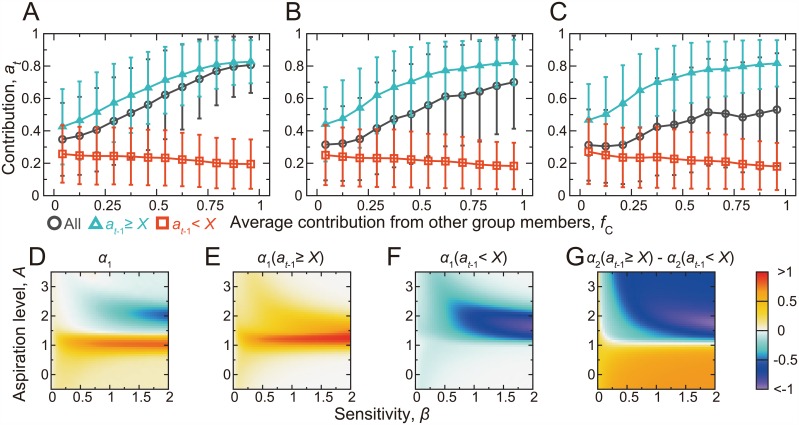
CC and MCC patterns in the repeated PGG in a group of four players.(A)–(C) Contribution by a player (i.e., at) conditioned on the average contribution by the other group members in the previous round (i.e., fC). We set β = 0.4 and A = 0.9. (A) X = 0.3, (B) X = 0.4, and (B) X = 0.5. The circles represent the results not conditioned on at−1. The triangles and the squares represent the results conditioned on at−1 ≥ X and at−1 < X, respectively. (D) Slope α1 of the linear fit, at ≈ α1
fC + α2, when not conditioned on at−1. (E) α1 when conditioned on at−1 ≥ X. (F) α1 when conditioned on at−1 < X. (G) Difference between α2 obtained from the linear fit conditioned on at−1 ≥ X and that conditioned on at−1 < X. The mean and standard deviation in (A)–(C) and the linear fit used in (D)–(G) were calculated on the basis of the four players, tmax = 25 rounds, and 2.5 × 104 simulations, yielding 2.5 × 106 samples in total.